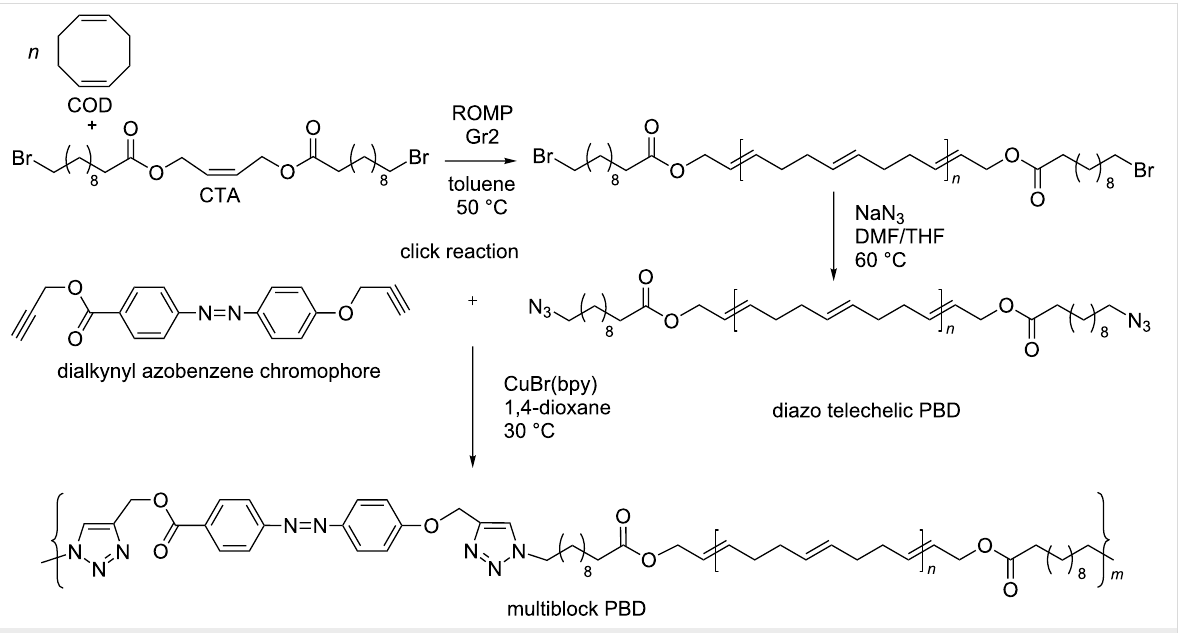
Scheme 3: Multiblock copolymer synthesis by combining ROMP and click reactions replotted from [61].